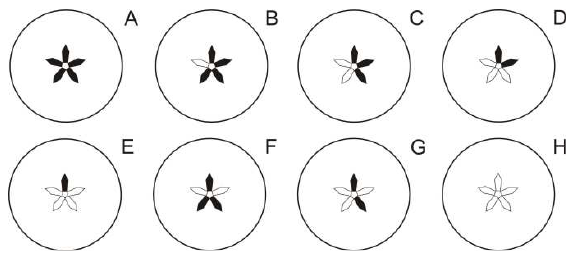
F IGURE 2. Carpel categories used to represent all combination of seed distribution among the five carpels of McIntosh